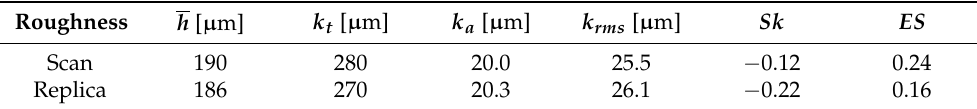
Figure 3. Comparison between scanned and replicated cast iron surface for the experiments. Table 2. Comparison of the roughness topographical properties between the cast iron scan and the